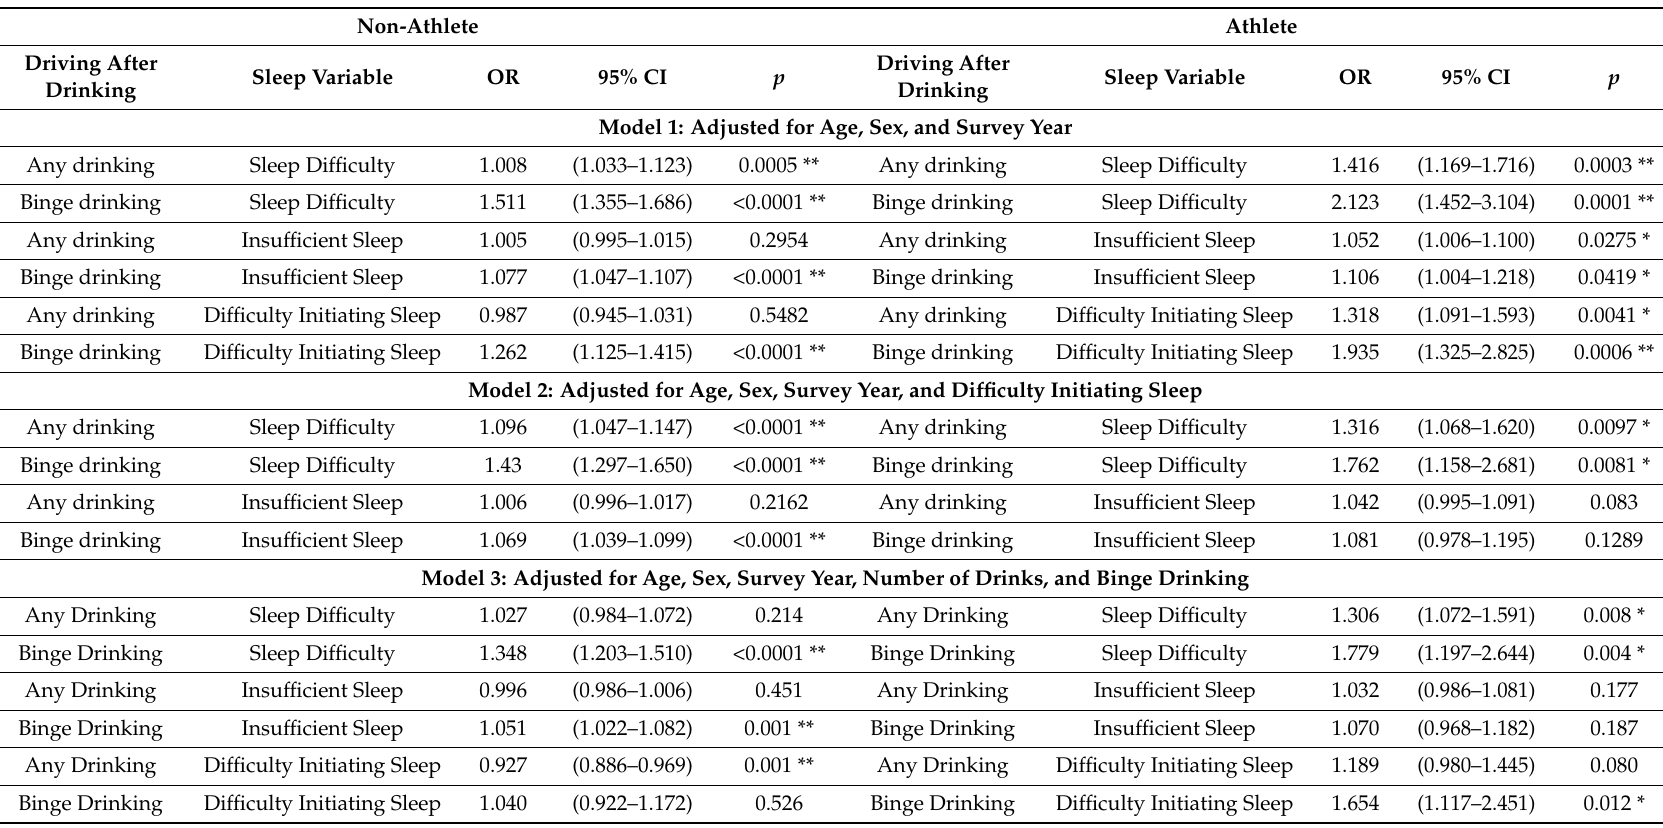
Table 3 Caption: Results displayed as Odds Ratio (OR) and 95% Confidence Interval (95% CI). The total number of analyses was 3 (sleep variables) × 2 (drinking outcomes) × 2 (athlete status), or 12 tests for models 1 and 3, and 8 tests for model 2 (due to inclusion of difficulty initiating sleep as a covariate). This yields a total of 32 tests. If a Bonferroni correction